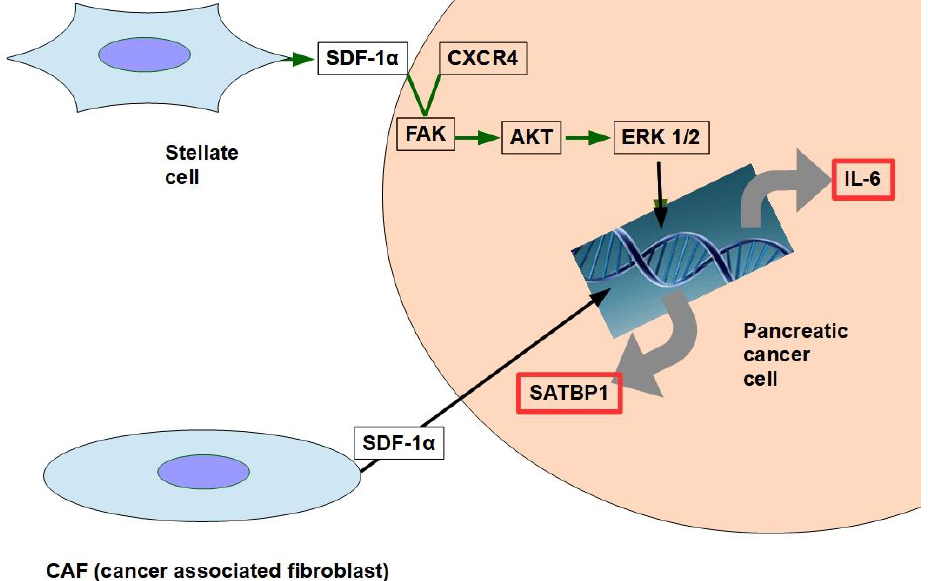
Figure 8. The two pathways shown in the figure have been found to decrease gemcitabine’s cytotoxity and apoptosis. SDF-1 α expression is induced by galectin 1.